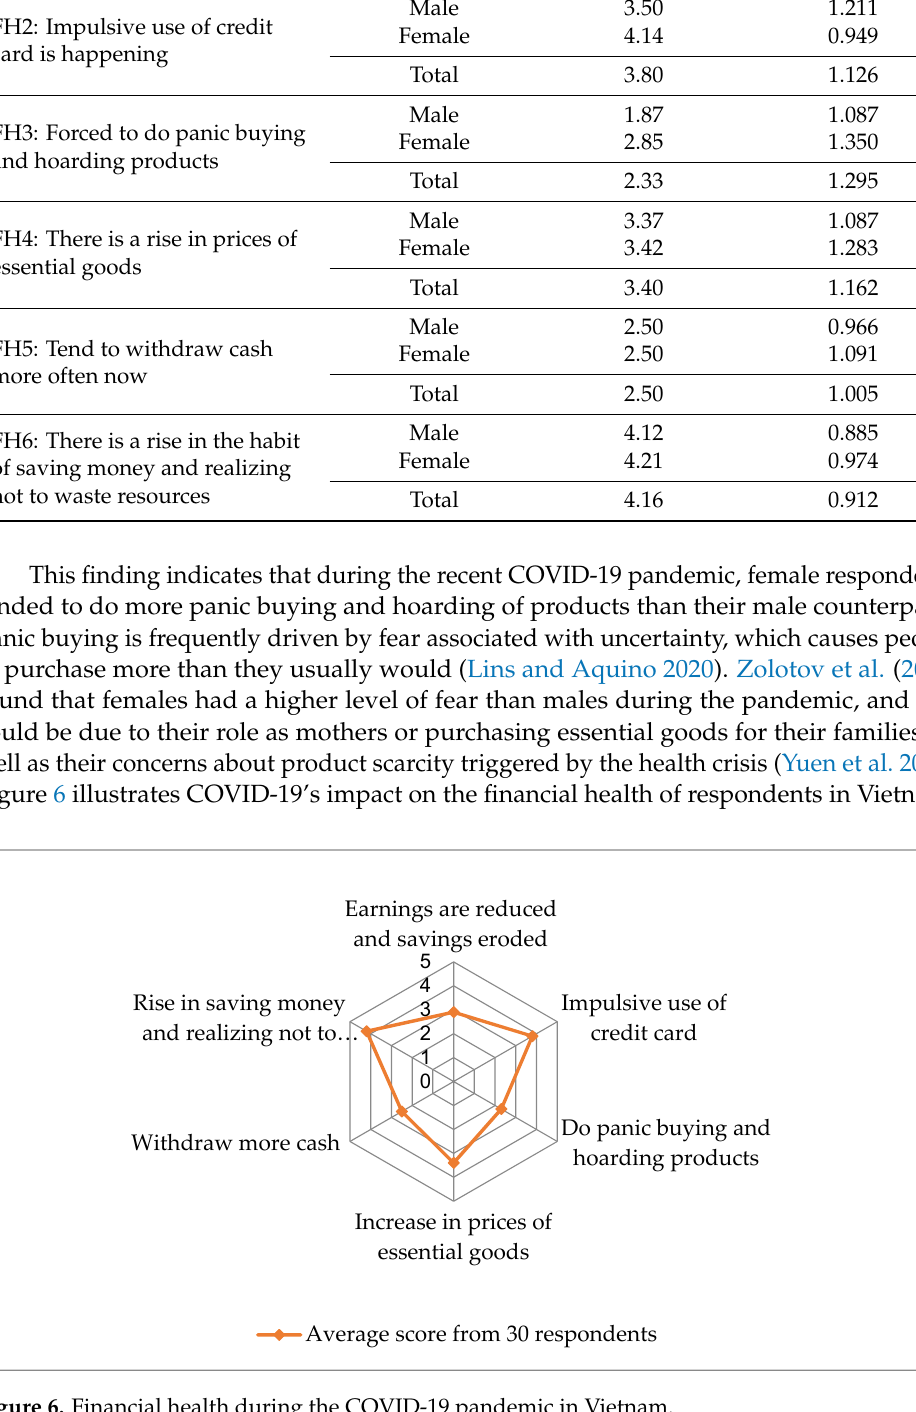
Figure 6. Financial health during the COVID-19 pandemic in Vietnam.